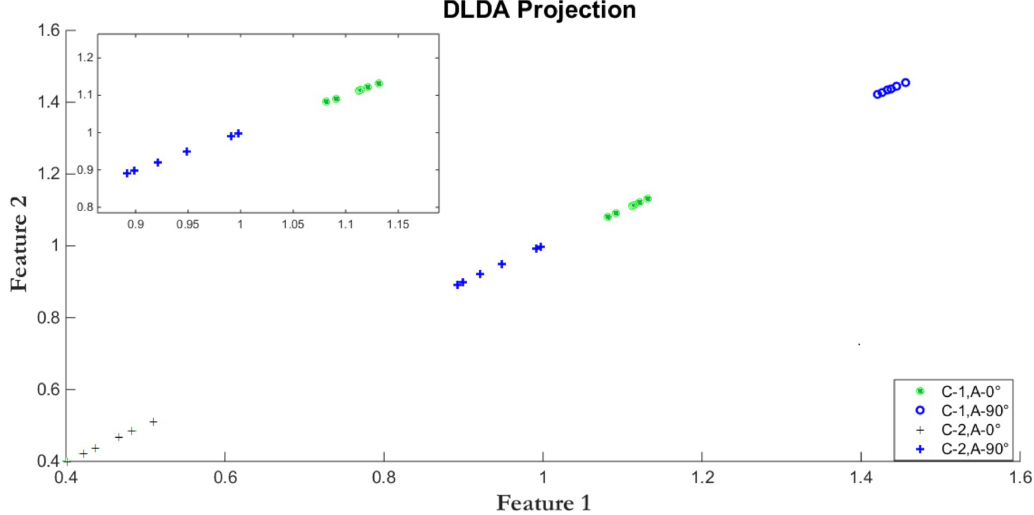
Figure 6. DLDA. The projection is prone to group the samples into classes rather than grouping then according to view